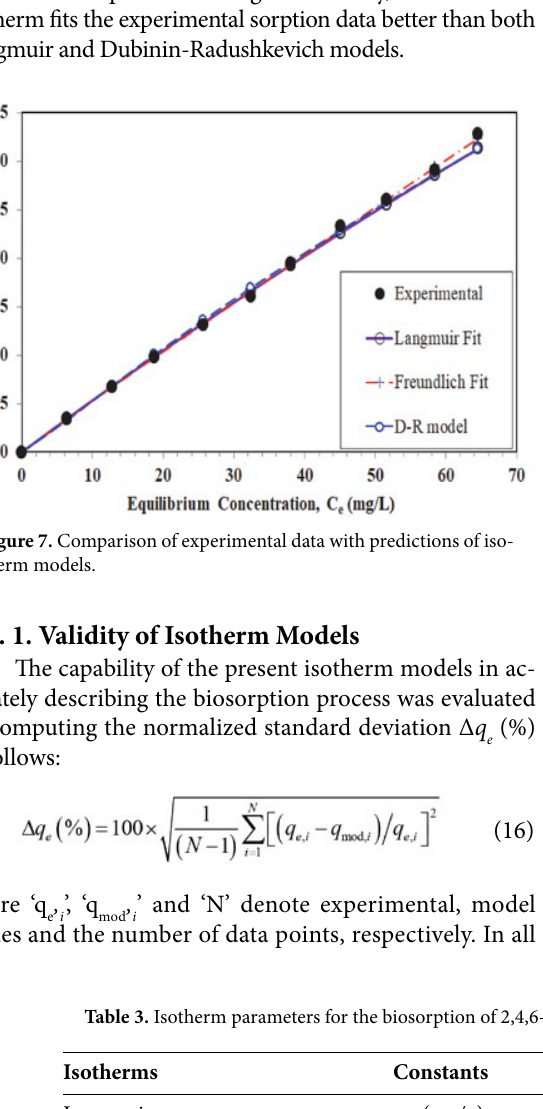
(mg/g) b (L/mg) m ((mg/g)(L/mg) 1/n ) F